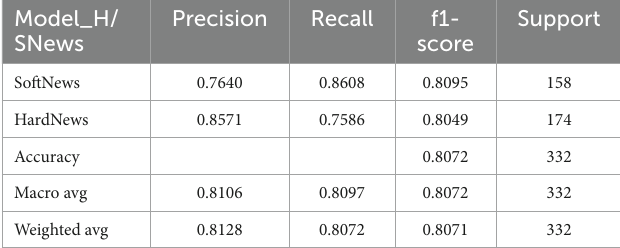
TABLE 1 Evaluation of model for hard and soft news.